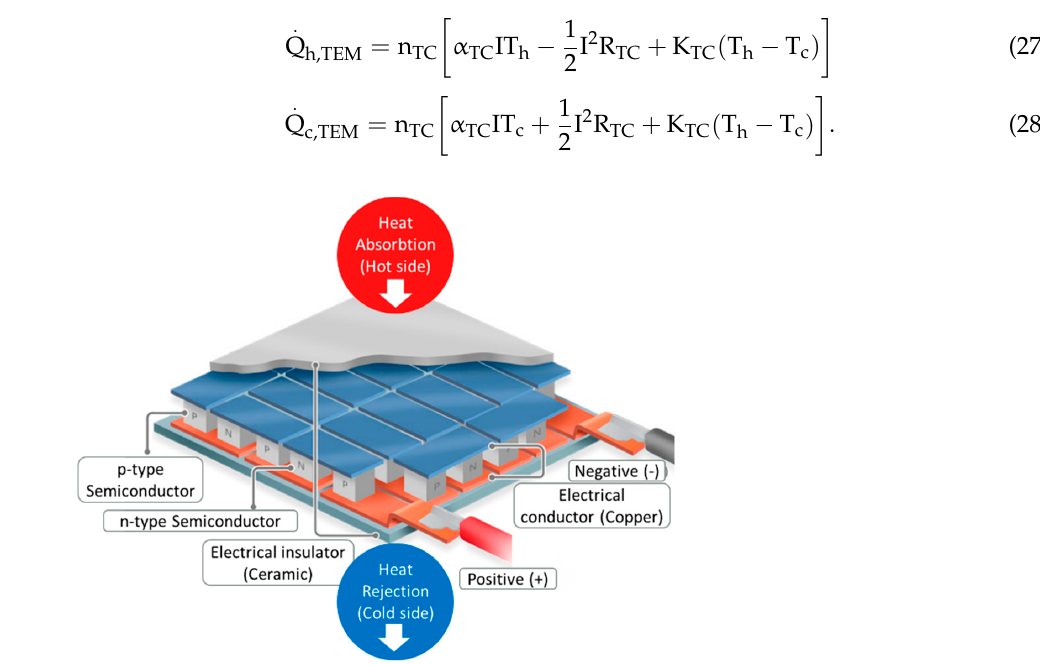
Figure 2. Thermoelectric module operating as a generator (based on